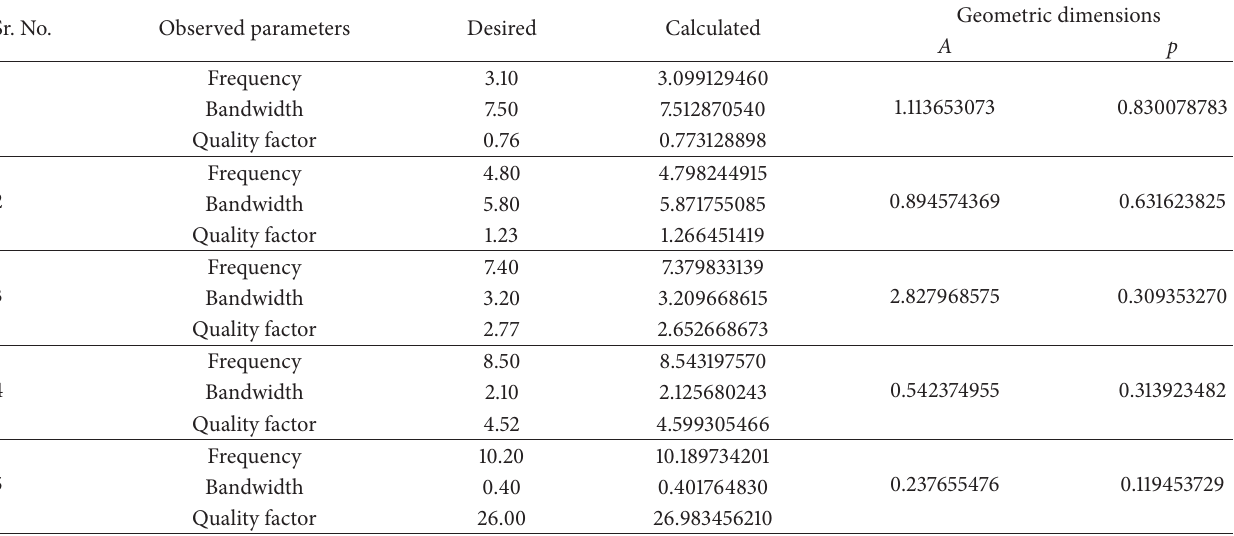
Table 2: Optimized values for PCMA at the lower frequency of 3.1, 4.8, 7.4, 8.5, and 10.2GHz. Sr. No.